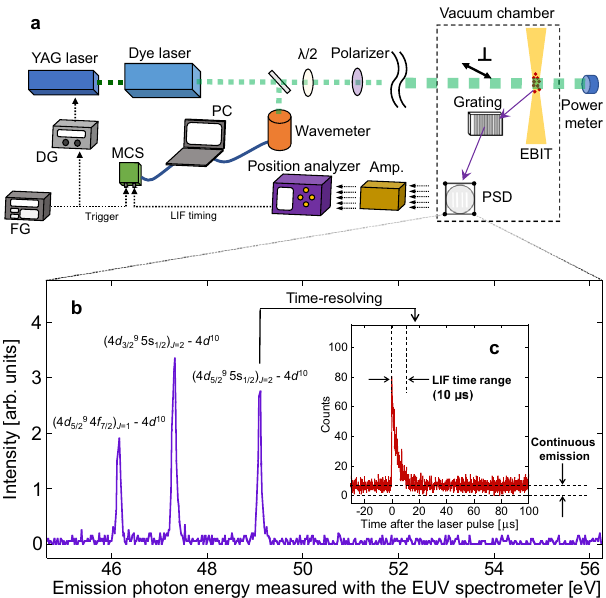
Fig. 3 Overview of the LIF detection setup. a Schematic of the experimental setup consisting of the electron beam ion trap (EBIT) with a time-resolved laser-induced fl uorescence (LIF) detection system. FG, DG, MCS, and PSD represent a Function Generator, Delay Generator, Multi- Channel-Scaler, and Position-Sensitive detector, respectively. b Typical EUV emission spectrum. c Time-resolved signal for the laser-induced E 2 transition fl